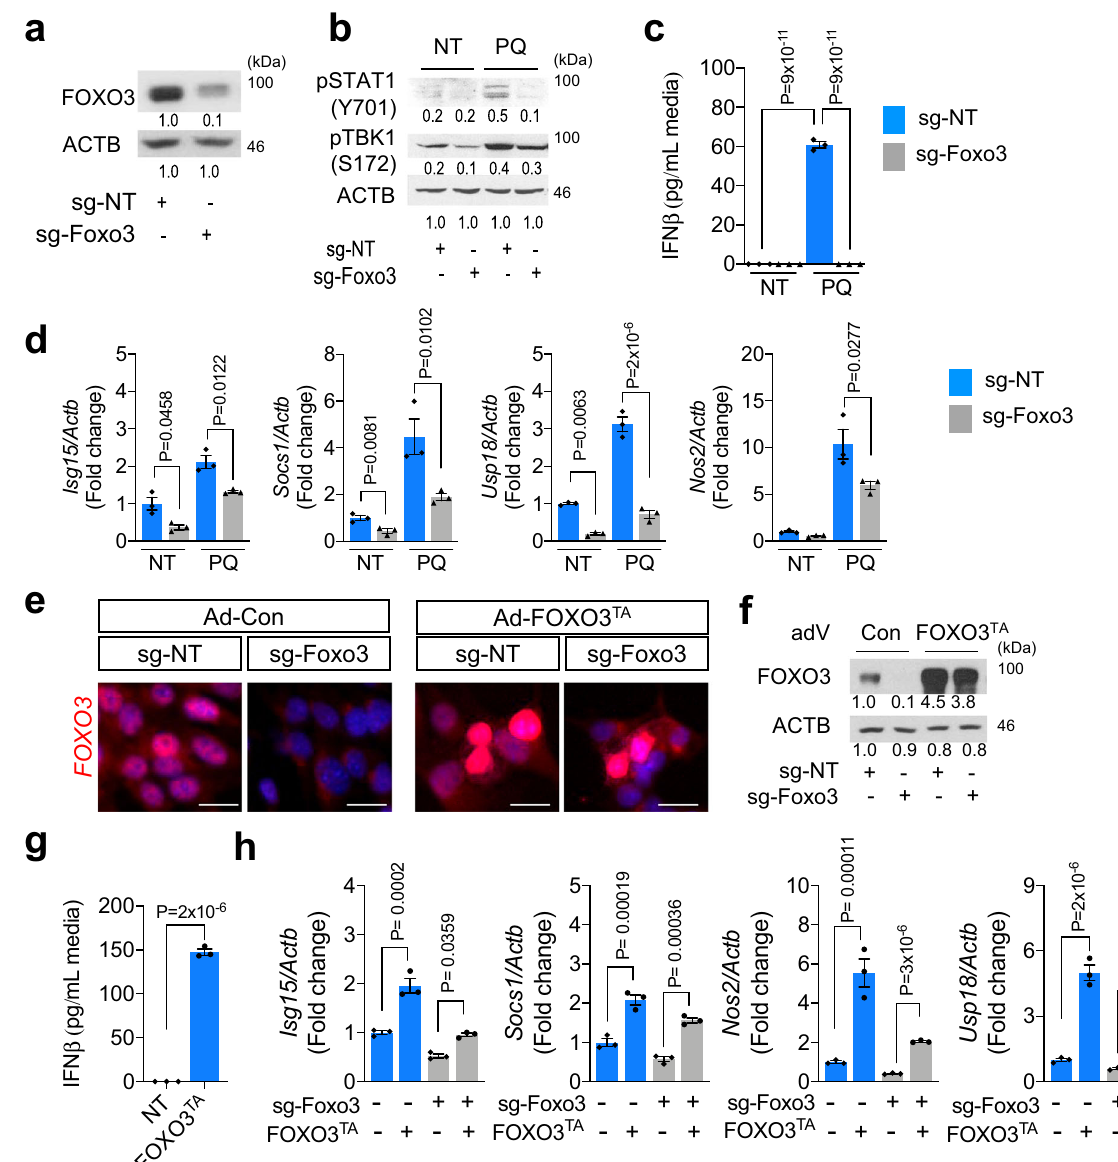
Fig. 2 FOXO3 is necessary for ROS-induced IFN-I response. a WB for FOXO3 in NSPCs expressing non-targeted guide RNA (sg-NT) or Foxo3 targeted guide RNA (sg-Foxo3). b WB for STAT1 and TBK1 phosphorylation following 48 h treatment. NT: mock-treated control, PQ: 5 μ M of paraquat. c IFN β secretion in the media following 48 h treatment. Mean± s.e.m. of three independent experiments. d qRT-PCR results for ISGs following 4 days of PQ treatment. Mean± s.e.m. of three independent experiments. Representative IF ( e ) and WB ( f ) results for FOXO3 on either adenovirus for control or FOXO3 TA -infected NSPCs. Scale bar = 10 µ m. g IFN β secretion in the media following 72 h of control or FOXO3 TA adenovirus infection. Mean ± s.e.m. of three independent experiments. h qRT-PCR results for ISGs at 4 days after the infection of adenovirus. Mean± s.e.m. of three independent experiments. Statistical signi fi cance was determined by one-way ANOVA for ( c , d , and h ), and by two-sided unpaired t -test for g Experiments for a , b , e , and f were repeated three times independently with similar results and representative images/blots are